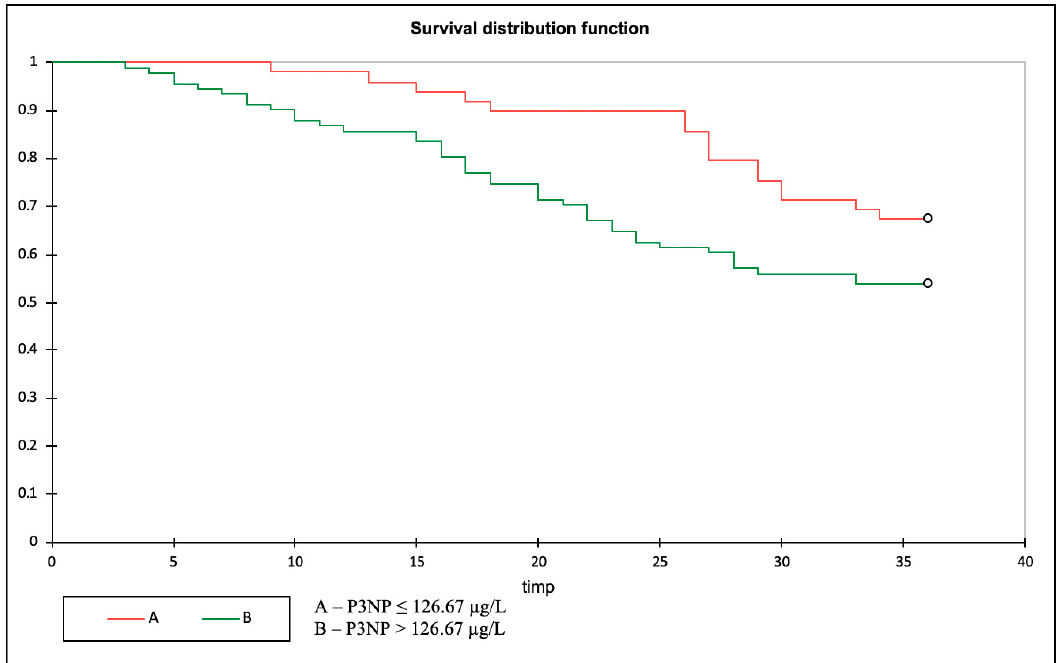
Figure 2. Kaplan–Meier curve displaying the impact of P3NP levels on all-cause